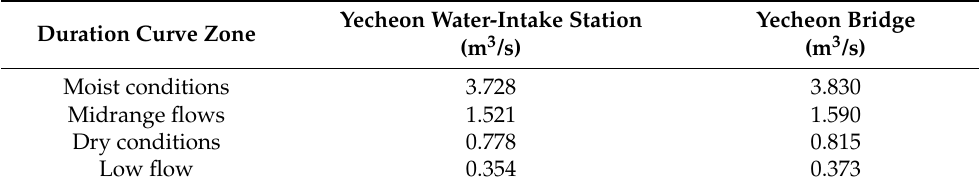
Table 4. Results of flow-duration analysis for Yecheon Water Intake Station and Yecheon Bridge.